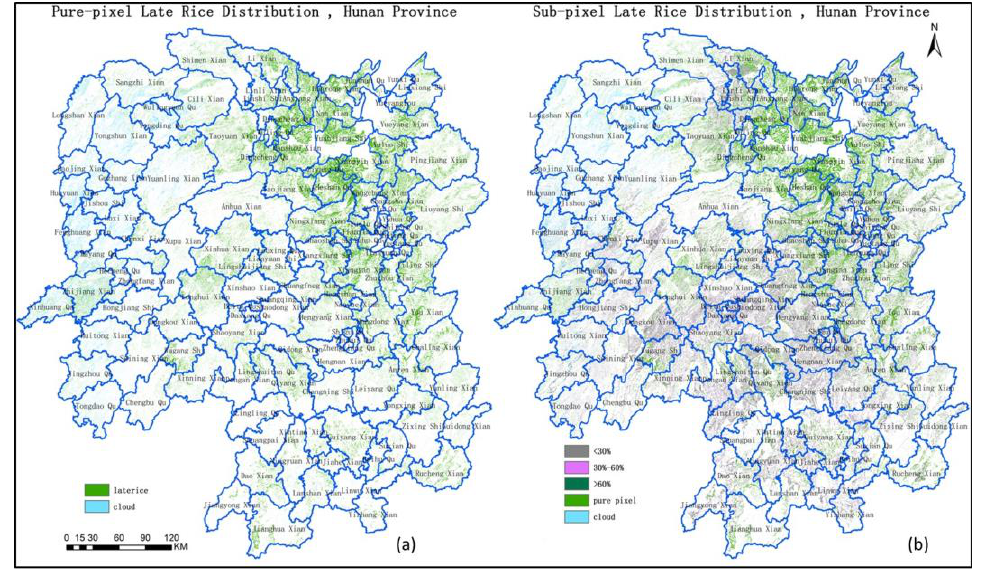
Figure 4. Pure-pixel, sub-pixel comparisons of late-season rice distribution